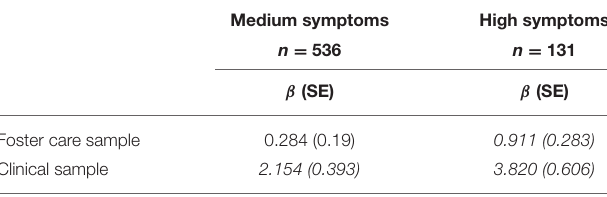
TABLE 4 | Anxiety and depression symptom profile representation among youth in foster care ( n = 245) and clinical youth ( n = 107) compared to a general population youth sample ( n =